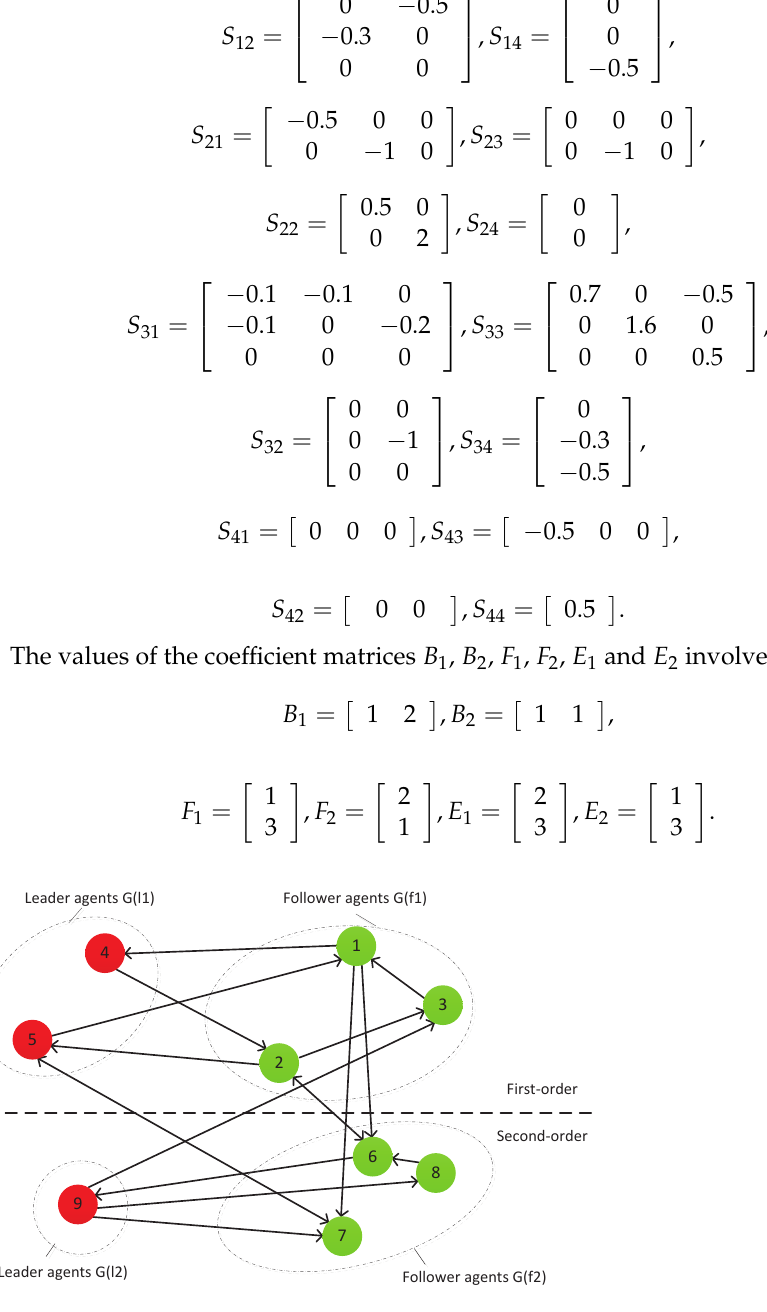
Figure 2. A MAS composed of nine